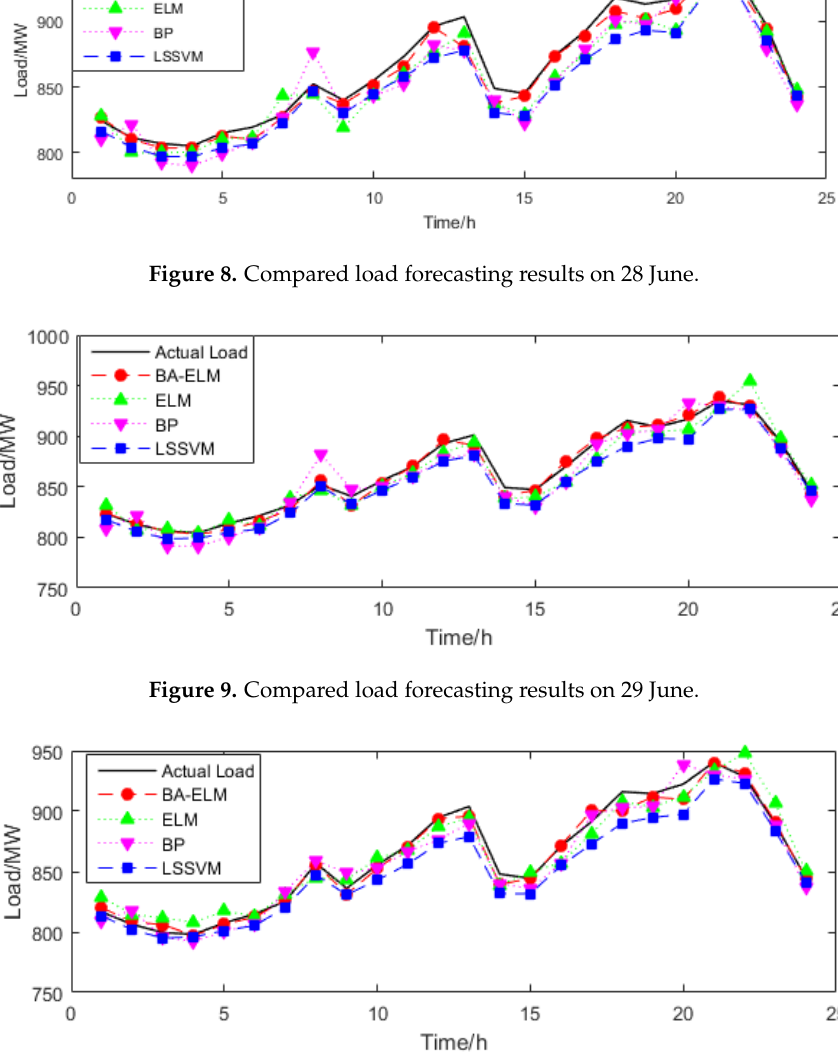
Figure 10. Compared load forecasting results on 30 June.